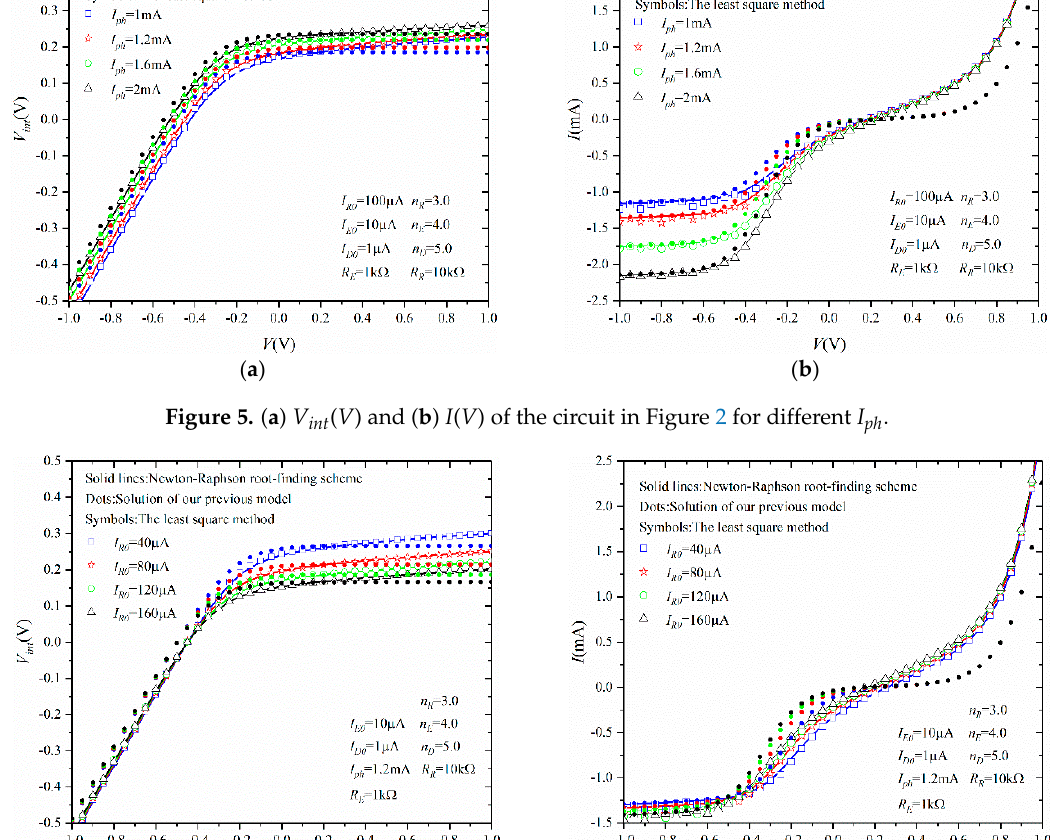
( b ) Figure 3. ( a ) V int ( V ) and ( b ) I ( V ) of the circuit in Figure 2 for different R E .